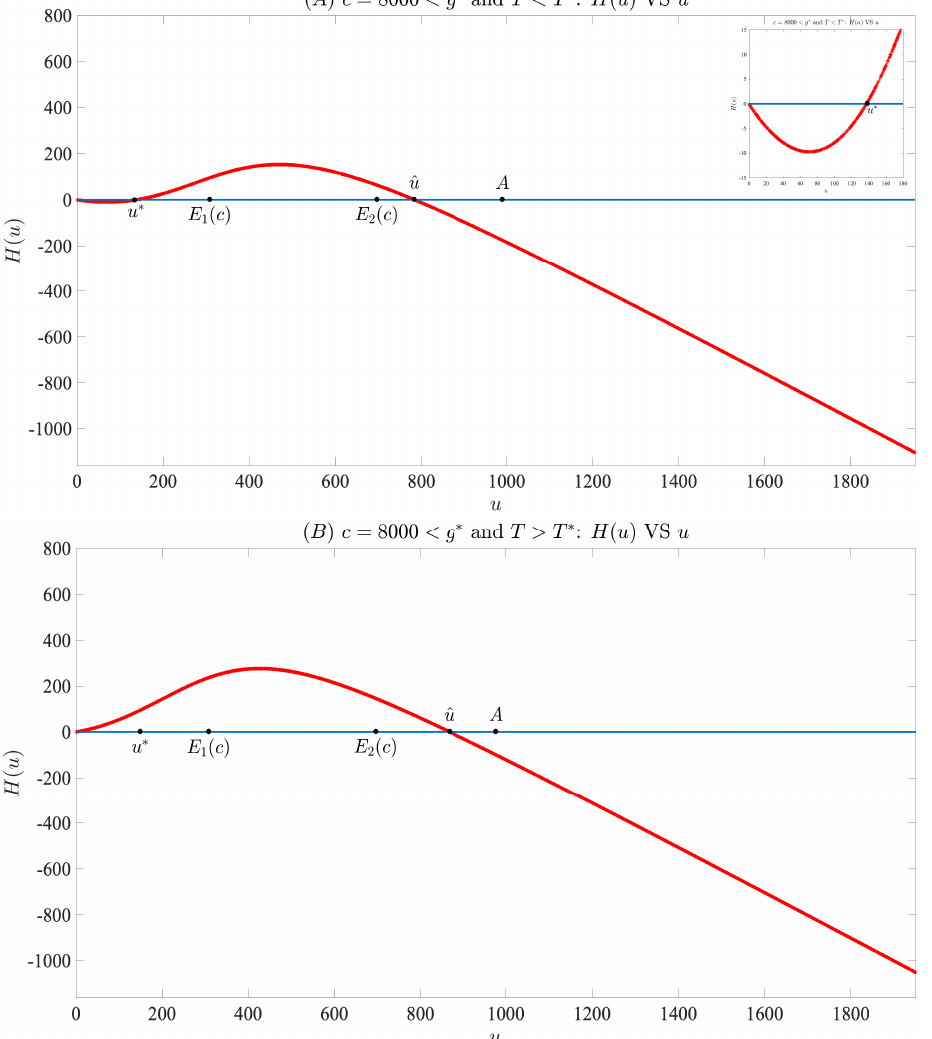
Figure 6. When parameters a , µ , ξ , ¯ T are specified in (51) and c = 8000 < G ∗ , we derive the above two plots, which support Lemmas 4–7 and Theorems 2 and